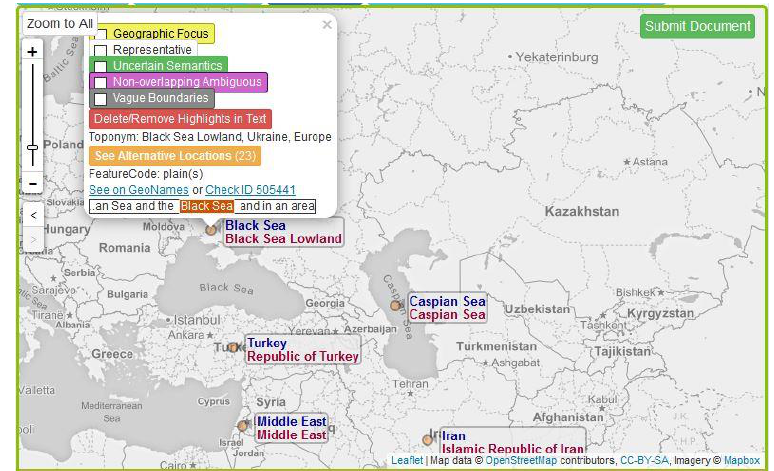
Figure 9. Clicking on each toponym invokes a popup displaying a list of special tags, the spatial hierarchy of the toponym, its feature code (type) and link to entries on GeoNames for more information on each toponym. Users can use the “see alternative locations” button to see alternative toponym candidates for a place